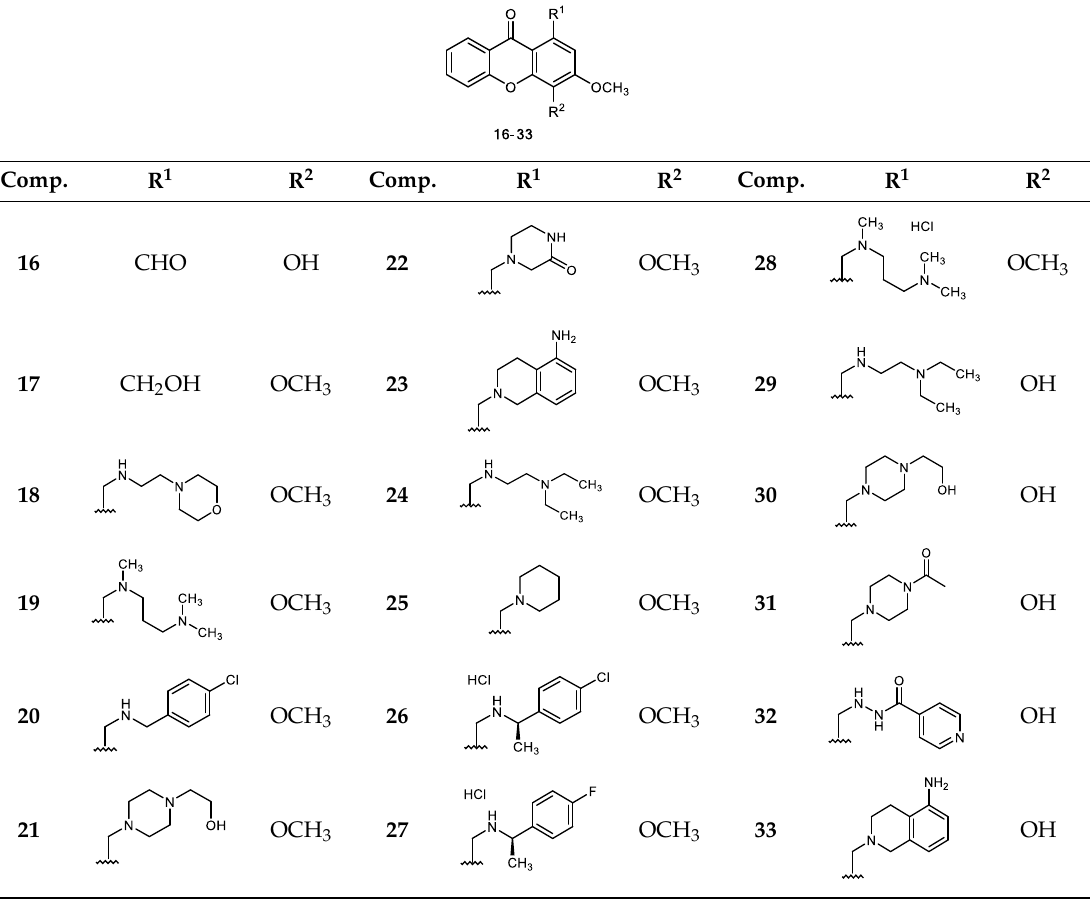
Table 3. Structures of previously synthesized compounds 16–33 .